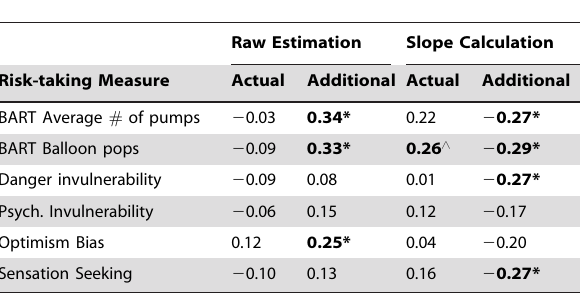
Table 3. Correlations between measures of risk-taking and responses from the balloon estimation